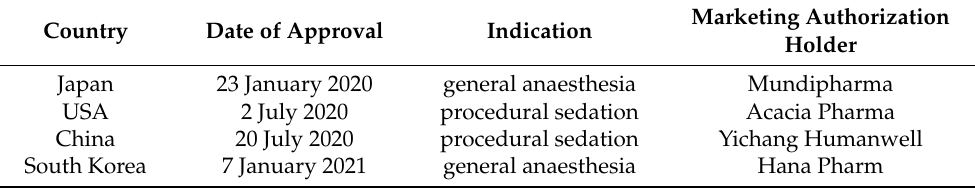
Table 1. Approvals of